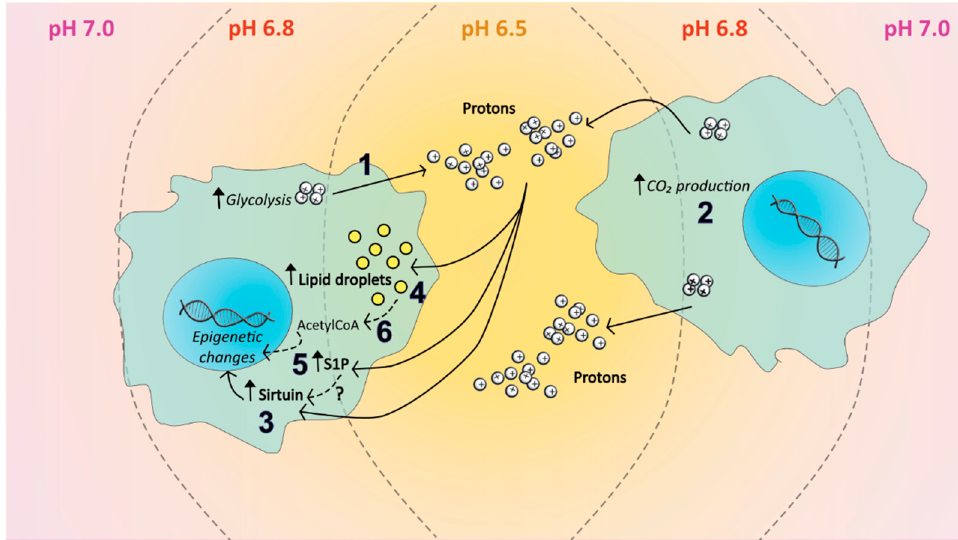
Figure 5. Possible mechanisms induced by acidosis in the TME. Extracellular acidosis results from the extrusion of protons in the TME from highly glycolytic cancer cells (1), or by the production of CO 2 from adjacent cells (2). Acidosis, in turn, stimulates sirtuin(s) activity (3) and induces stress in tumour cells, which causes the accumulation of lipids inside the cell, in the form of lipid droplets, (4), and an increase in intracellular S1P (5) and Acetyl-CoA (6). The increased Acetyl-CoA and S1P concentration may lead to inhibition of HDAC1/2 and overexpression of SIRT1, thereby resulting in epigenetic changes.